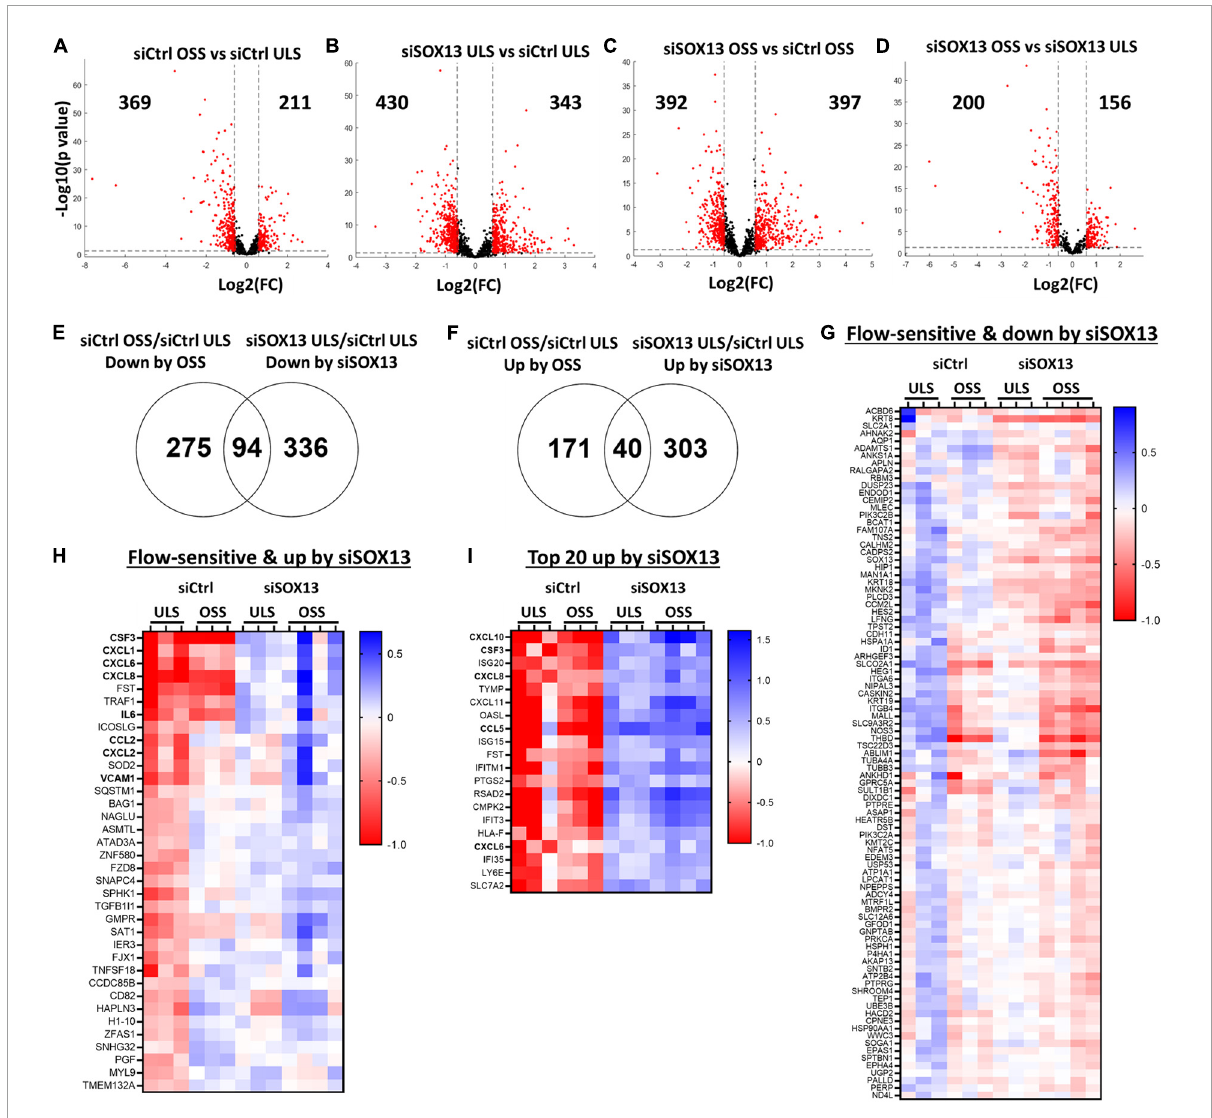
FIGURE4 Shear-dependent and SOX13-dependent gene expression in HAECs by RNAseq analysis. HAECs treated with siSOX13 or siCtrl for 24 h were exposed to OSS or ULS for another 24 h, and total RNAs were analyzed by RNAseq. (A–D) Shows differential gene expression by comparing the four groups: (1) siCtrl OSS, (2) siSOX13 OSS, (3) siCtrl LSS, and (4) siSOX13 LSS. The number of significantly downregulated (left) or upregulated (right) genes by ≥ 50% with a p -value ≤ 0.05 (shown as red dots) are indicated in each volcano plot. (E,F) Venn diagrams show commonly downregulated genes by OSS or siSOX13 (E) and upregulated genes by OSS or siSOX13 in ULS condition (F) . (G,H) Heat map of the 94 commonly downregulated genes by OSS or siSOX13 in ULS condition (G) and the 40 commonly upregulated by OSS or by siSOX13. (I) Heatmap of top 20 genes upregulated by siSOX13 regardless of shear